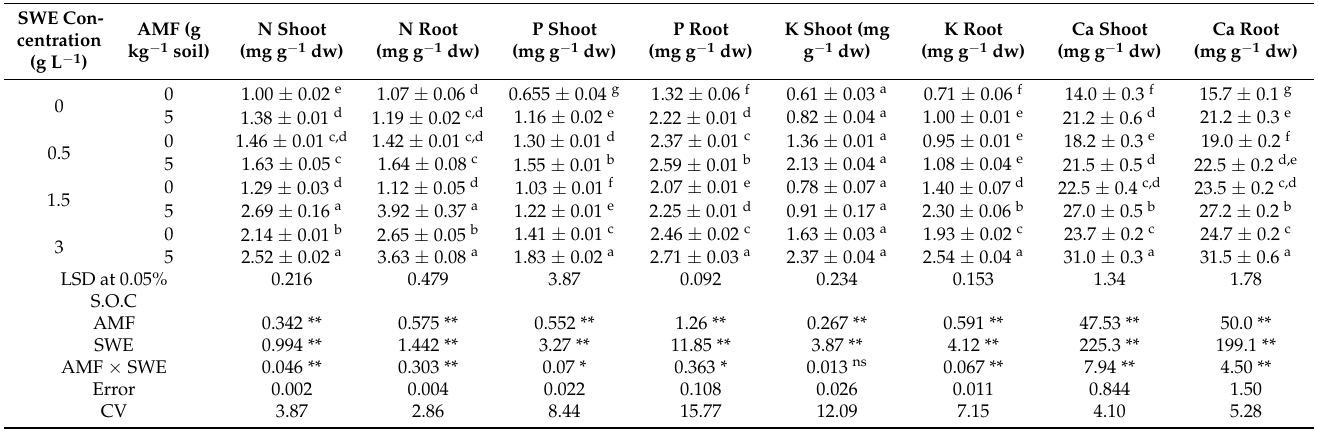
Table 4. The macrominerals content in lettuce plants treated with arbuscular mycorrhiza fungi (AMF) and seaweed extract